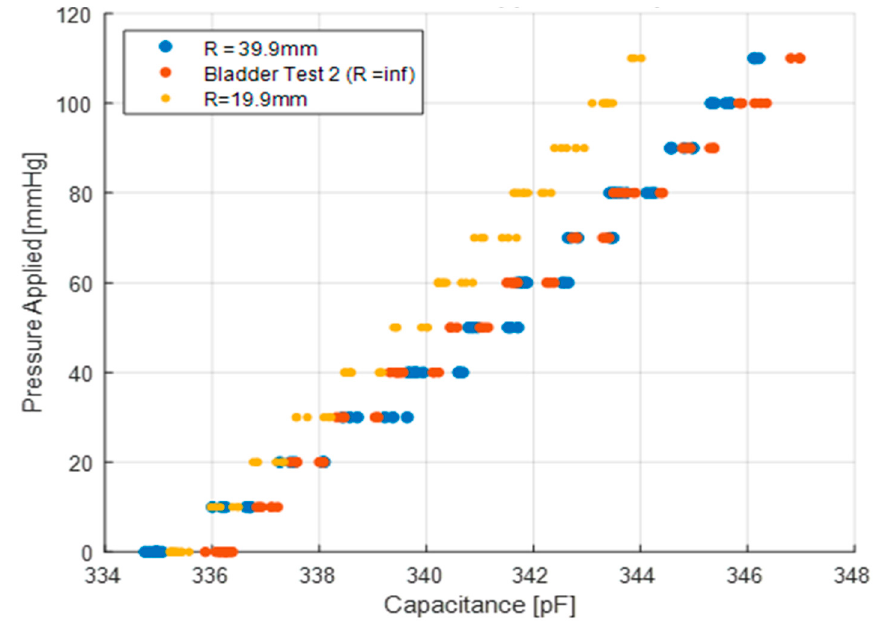
Figure 13. Pressure vs sensor capacitance for various radii of curvature.